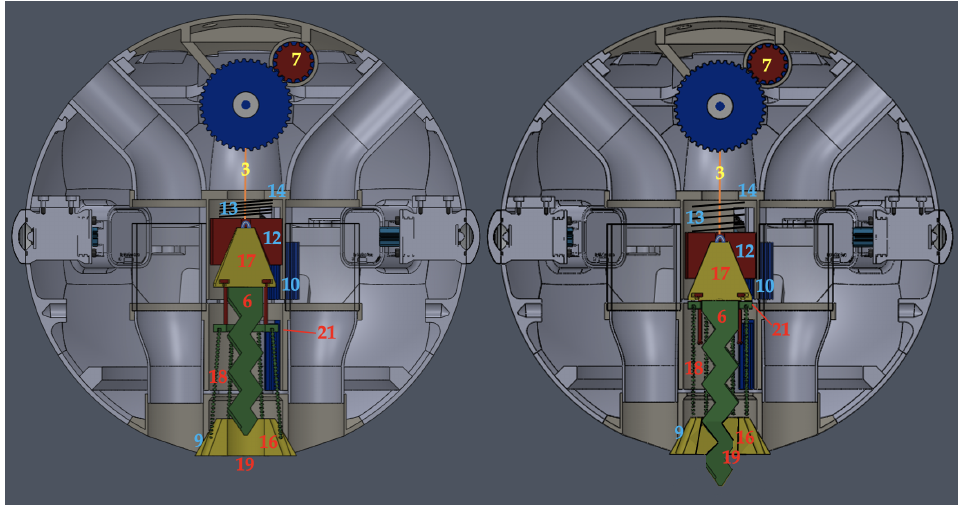
Figure 8. RAATM phase transition from stowed ( left ) to inject ( right )